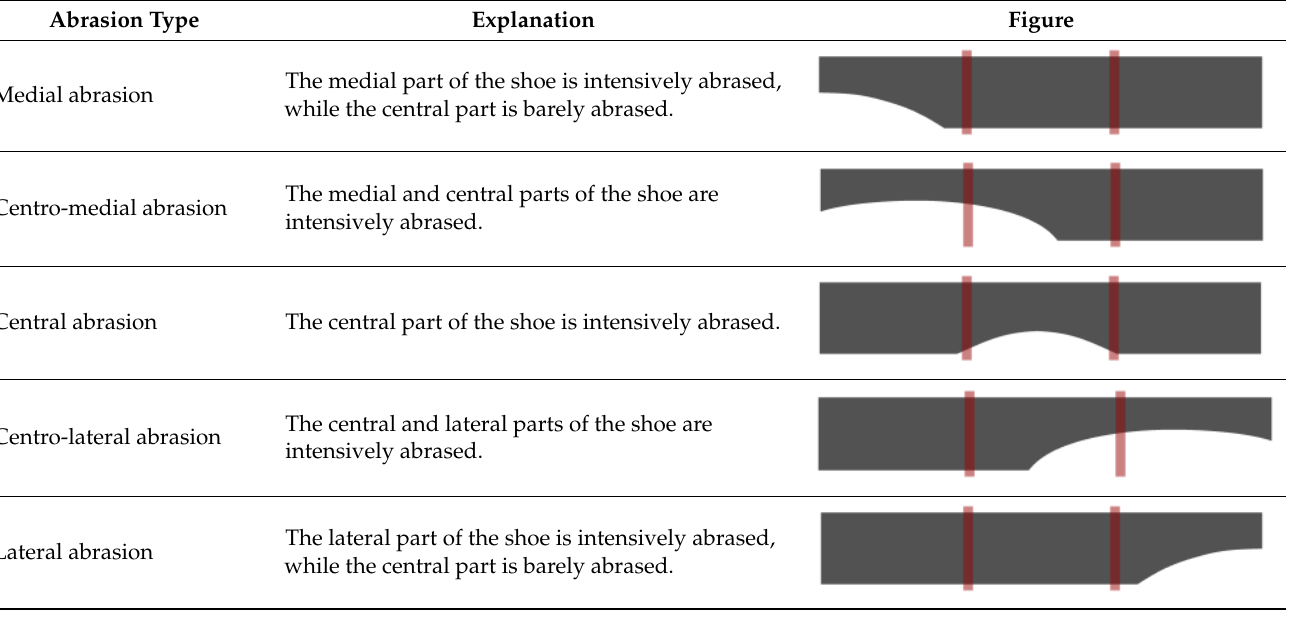
Table 2. Shoe abrasion types (adapted with permission from Ref. [5]. 2015, Baumfeld et